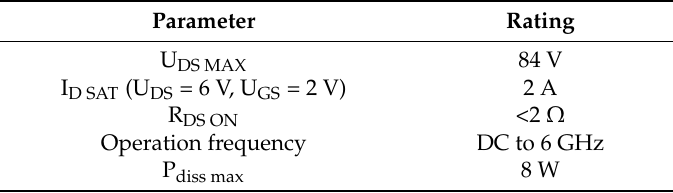
Table 1. GaN High-Electron-Mobility Transistors (HEMT) electrical